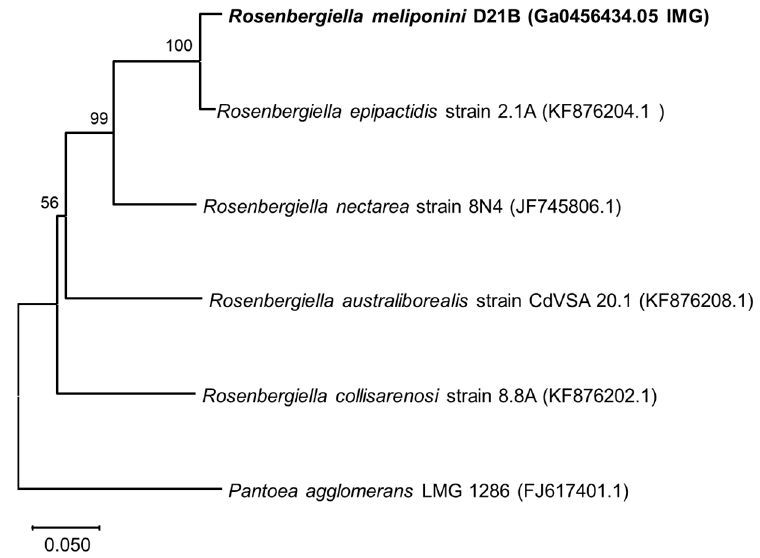
Figure 2. Neighbor-joining phylogenetic tree based on gyrB gene sequences. R. meliponini D21B and R. epipactidis 2.1A shared 97.26% sequence similarity. R. meliponini D21B exhibited 87.43%, 82.21%, and 81.19% sequence identity with R. nectarea, R. australiborealis, and R. collisarenosi , respectively. Bootstrap values > 50% calculated from 1000 replicates are indicated at branching nodes. Scale bar indicates 0.05 substitutions per nucleotide position.